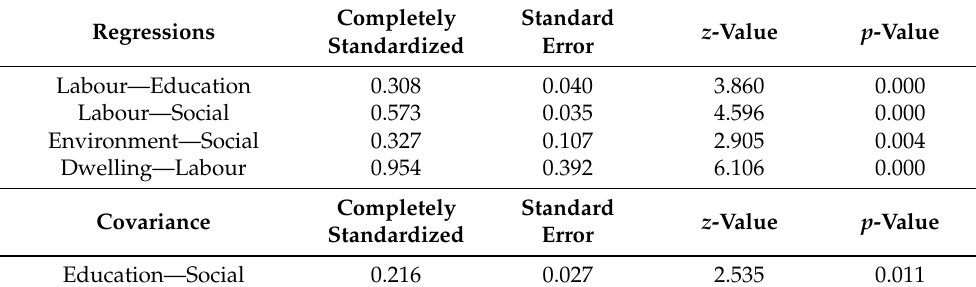
Table 5. Results of the regressions and the covariance of the structural model.